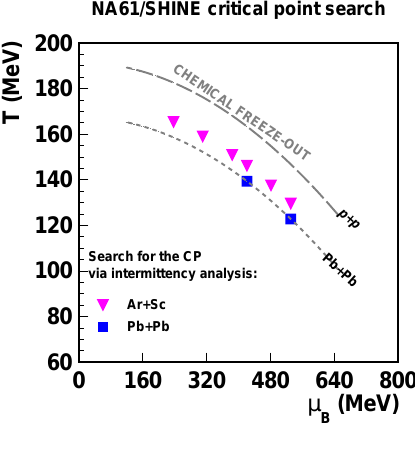
Figure 7. Diagram of chemical freeze-out temperature and chemical potential. The dashed line indicate parameters in p + p interactions and the dotted line in central Pb+Pb collisions [25]. The colored points mark reactions in the T − µ B phase diagram for which search for the critical point was